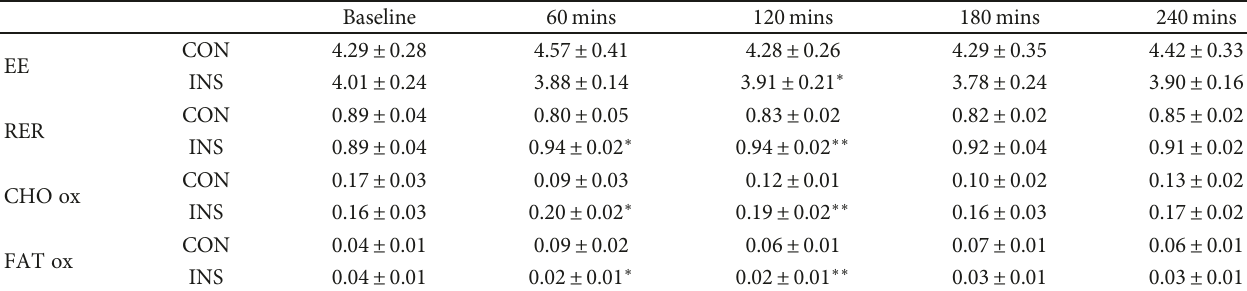
Table 2: Physiological and metabolic responses to the infusion of insulin (INS) and saline (CON) in patients with T2D whilst resting for four hours.